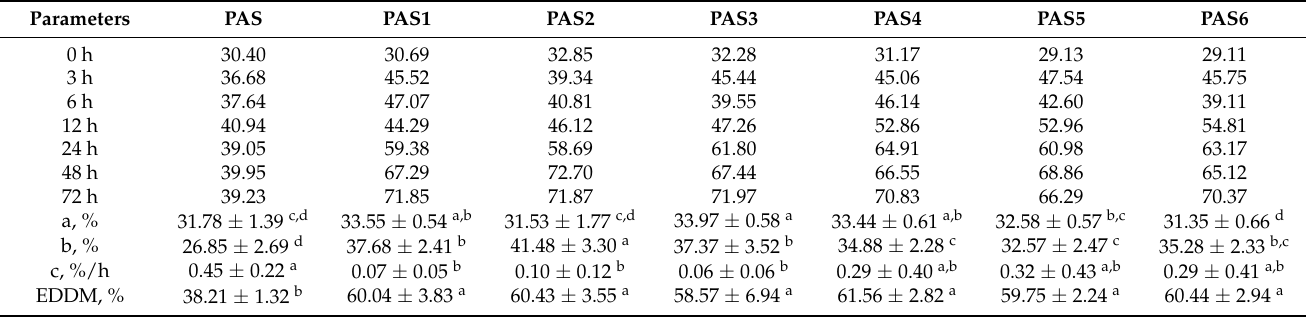
Table 2. Percentage dry-matter (DM) disappearance at different incubation periods and the ef- fective degradability of dry matter of in vitro-incubated pineapple waste silage with or without proteolytic enzyme.